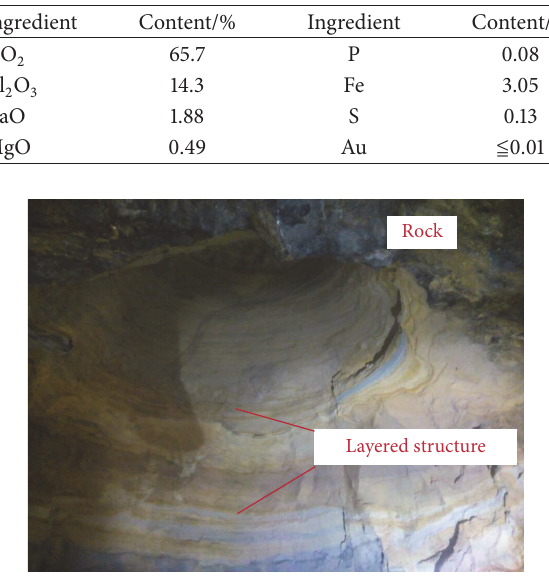
Figure 1: Stratification phenomenon of tailings backfill.